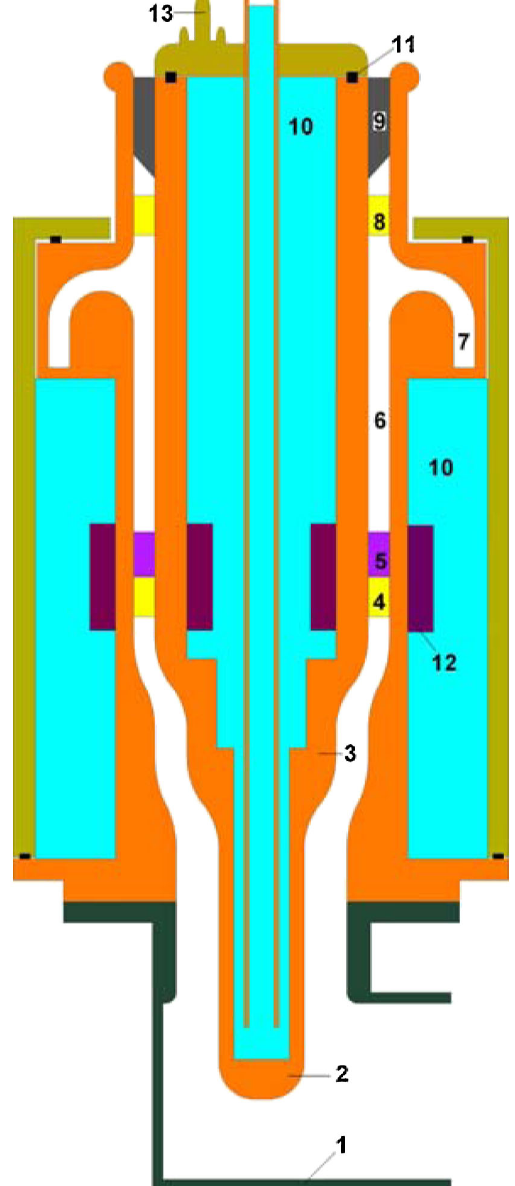
FIG. 12. Coaxial version (it is about 55 cm tall/ long, and 23 cm in diameter).